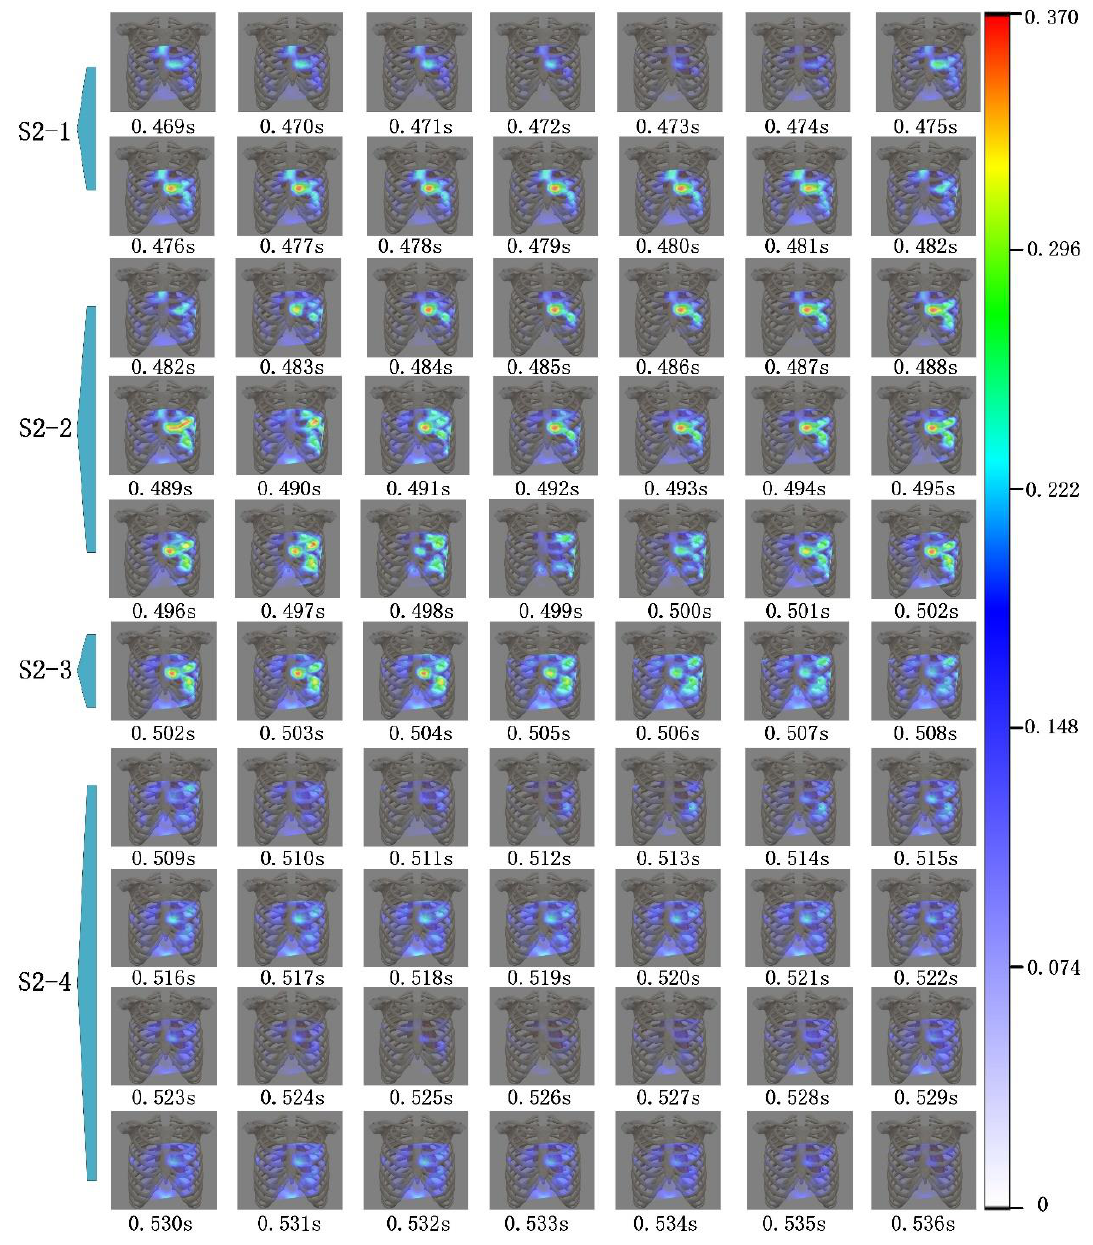
Figure 13. Cardiac acoustic maps of S2. The stages of S2-1, S2-2, S2-3, and S2-4 are indicated in Figure 11.